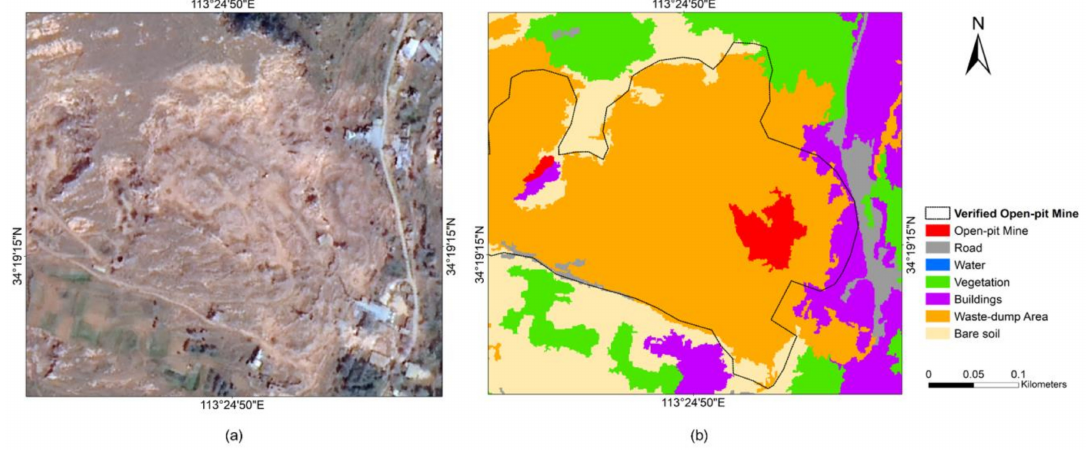
Figure 15. Abandoned OM in the study area. ( a ) GF-2 image; ( b ) CNNOMM